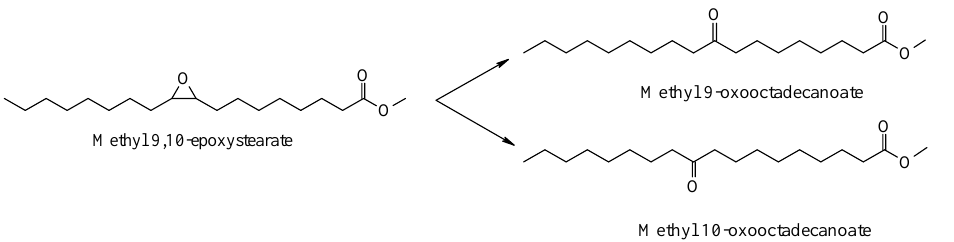
Figure 14. Rearrangement of epoxides to generate two ketone isomers (Methyl 9-oxo- and 10-oxo- stearic acid) [41].